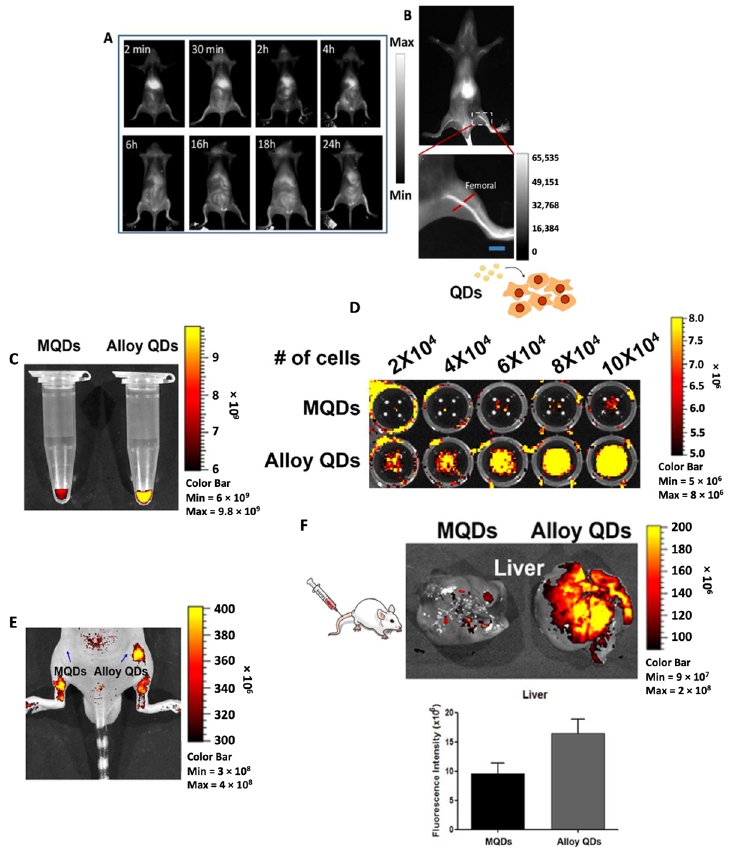
Figure 3. Representative images of NIR-II fluorescence imaging in BALB/c mice. ( A ) Full body distribution and ( B ) zoomed in image showing fluorescence from the femoral artery post-i.v. injection of Ag 2 S QDs. [Reprinted with permission from Ref. [43]. Copyright © 2023, Royal Society of Chemistry]. ( C ) Higher fluorescence intensity observed from the Eppendorf tube containing the same concentration of alloy QDs as compared to MQDs. ( D ) Cell number dependent increase in fluorescence intensity observed in HeLa cells treated with alloy QDs as compared to MQDs. ( E ) Higher fluorescence intensity observed in vivo in mice treated with alloy QDs. ( F ) Images of liver captured 1 h post-treatment showed higher fluorescence in mice treated with alloy QDs. Reprinted with permission from Ref. [44]. Adopted from BioMed Central 2022.